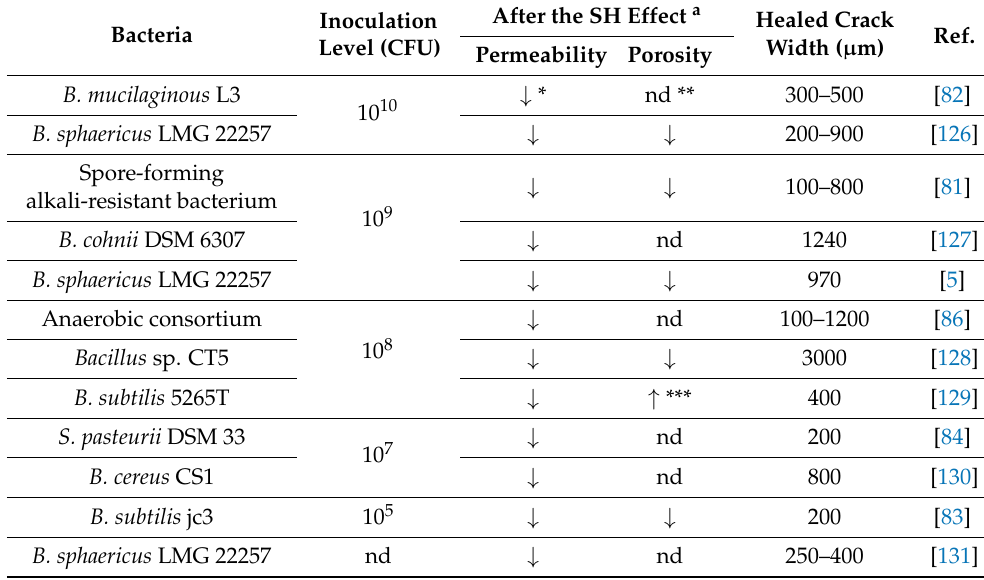
Table 3. Changes in porosity and permeability of freshly prepared